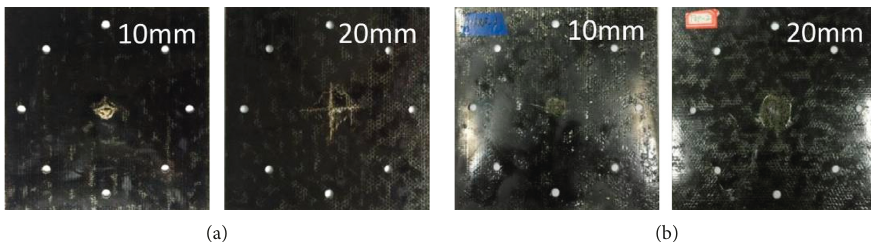
Figure 12: Failure modes of the BFRP plate under two sizes of projectile: (a) static indentation; (b) drop-weight